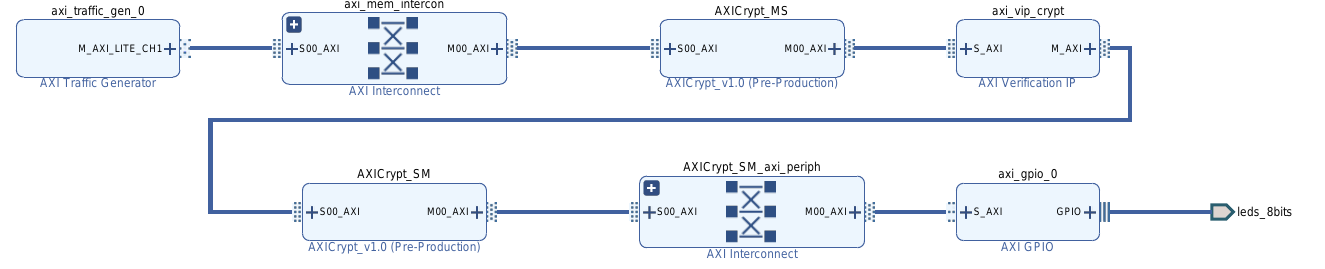
Figure 5. Block diagram of the example